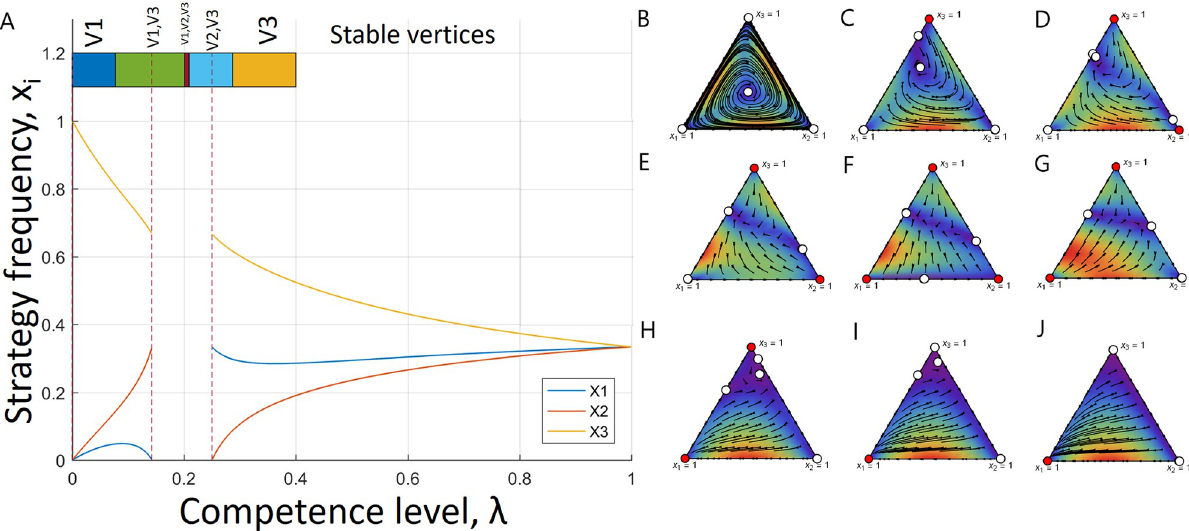
Fig 3. Game transitions under execution errors from example 2. (A) Frequencies of each strategies in the interior equilibrium as functions of λ . Here, x 1 represents rock frequency, x 2 —paper frequency and x 3 —scissors frequency. The interior equilibrium exists for most the values of λ but ( 1 7 = , 1 4 = ). Further, the coloured bar at the top of the plot indicates stability intervals of λ for different vertices (a stable vertex is indicated on top of the bar). For instance, vertex 3 is the only stable vertex for λ 2 ( � 0.287, 2 = ). Game flow for the unstable rock-paper-scissors game is depicted for different values of 5 λ as follows: (B) λ = 1, (C) λ = 0.3, (D) λ = 0.27, (E) λ = 0.22, (F) λ = 0.205, (G) λ = 0.16, (H) λ = 0.1, (I) λ = 0.05, (J) λ = 0. We depicted each transition in the game from panel A. Here, a stable fixed point is denoted by a red circle and a unstable fixed point is denoted by a white circle. Hence, as λ changes its values from 1 to 0, the game experiences several transitions in its equilibria and for different degrees of execution errors, each of the pure strategies has a chance to dominate. However, for the maximum plasticity, only pure rock strategy